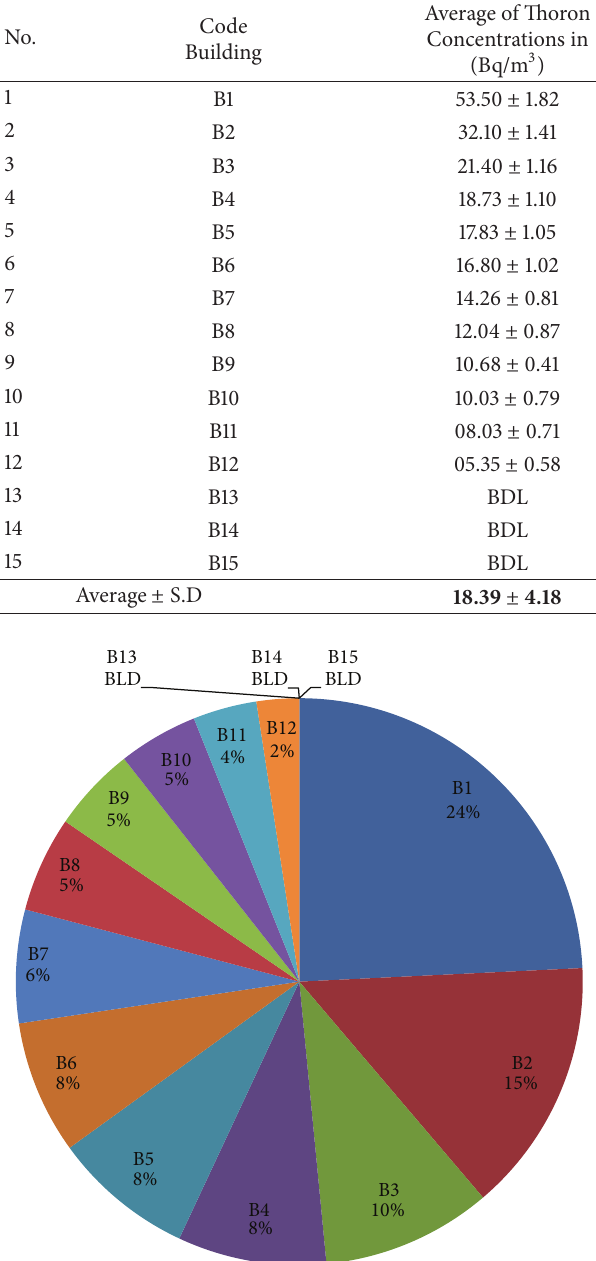
Table 3: Results of thoron progeny concentration and annual effective dose in study area.